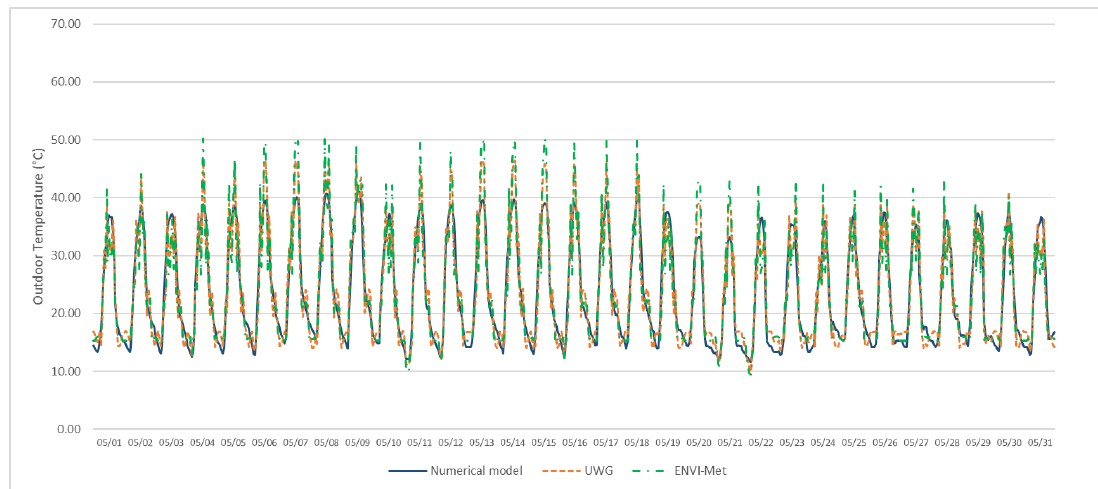
Figure 9. Hourly outdoor temperatures for May on Mexico City comparing the numerical model developed here, urban weather generator (UWG), and ENVI-Met.